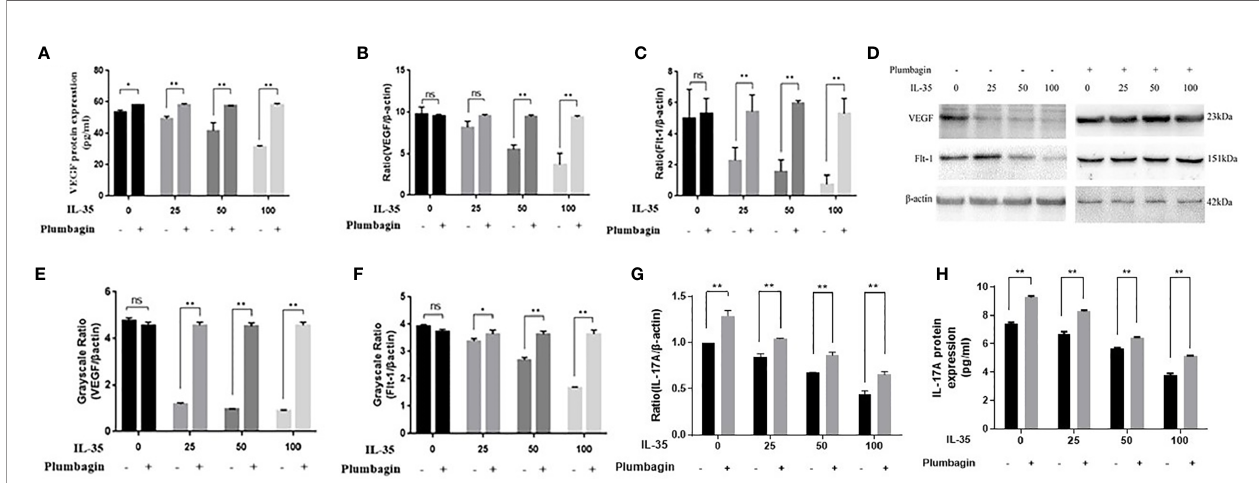
FIGURE 7 | (A) VEGF protein expression in the supernatant of osteoclasts were determined by ELISA, without or with blockage of plumbagin. (B, C) RT-PCR analysis of VEGF and its receptor mRNA expressions in osteoclasts with or without blockage of plumbagin. (D – F) Western blot analysis of VEGF and its receptor protein expressions in osteoclasts with or without blockage of plumbagin. (G) IL-17A protein expression in the supernatant of osteoclasts were determined by ELISA, without or with blockage of plumbagin. (H) RT-PCR analysis of IL-17A mRNA expressions in osteoclasts with or without blockage of plumbagin. Mean ± SD. n = 6. *P < 0.05, **P < 0.01. ns, no signi fi